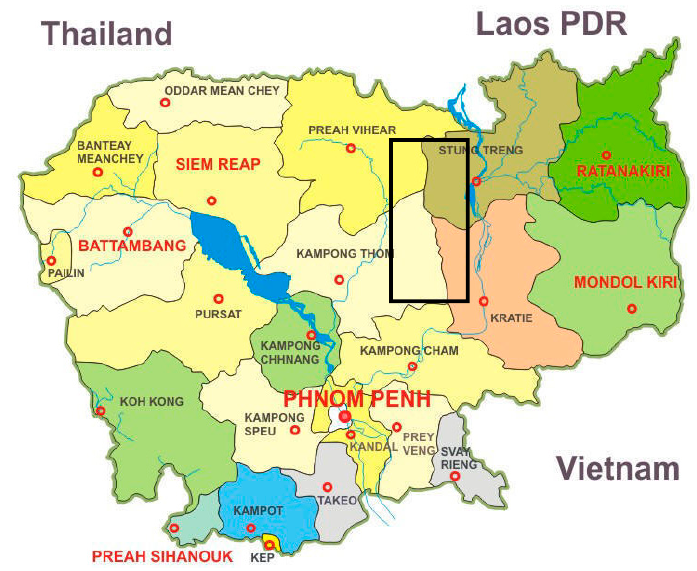
Figure 2. Prey Lang Wildlife Sanctuary (PLWS) in relation to provincial boundaries. Map from GoPhnomPenh http://gophnompenh.com/phnom-penh-overview/.